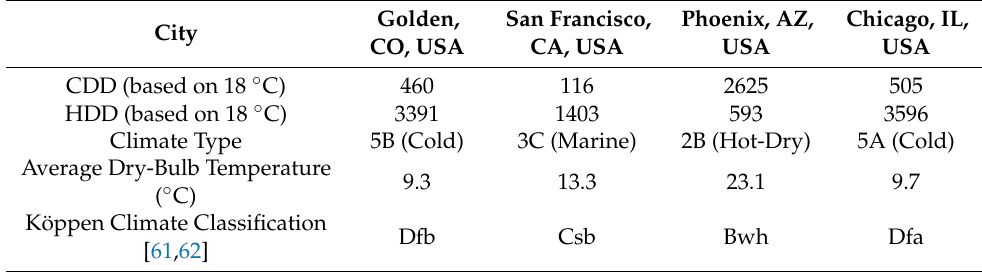
Table 5. Summary of the basic annual characteristics of all the locations used based on International Energy Conservation Code